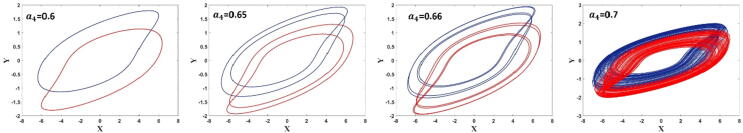
Various coexisting limit cycles and chaotic attractors when the initial conditions are 1,0,0,0 (shown in blue) and -1,0,0,0 (shown in red) for different values of a4.